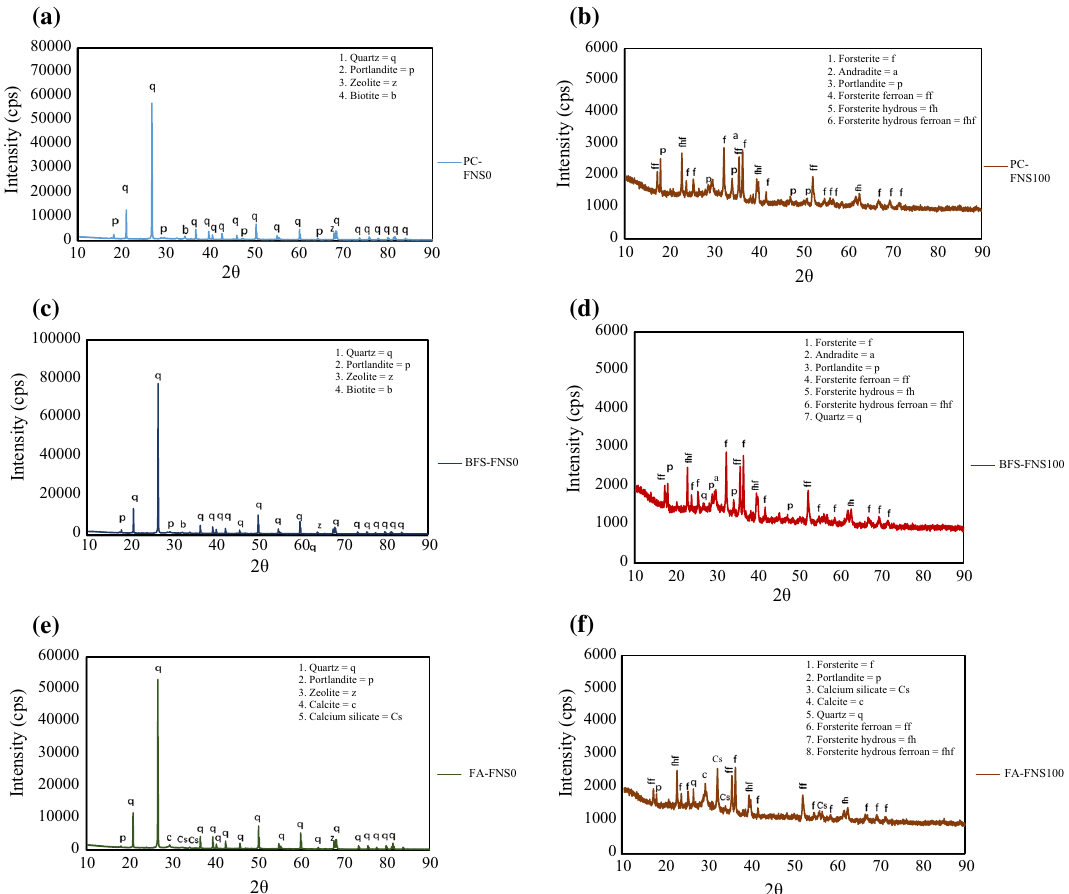
Fig. 10 XRD patterns of a PC-FNS0, b PC-FNS100, c BFS-FNS0, d BFS-FNS100, e FA-FNS0, and f